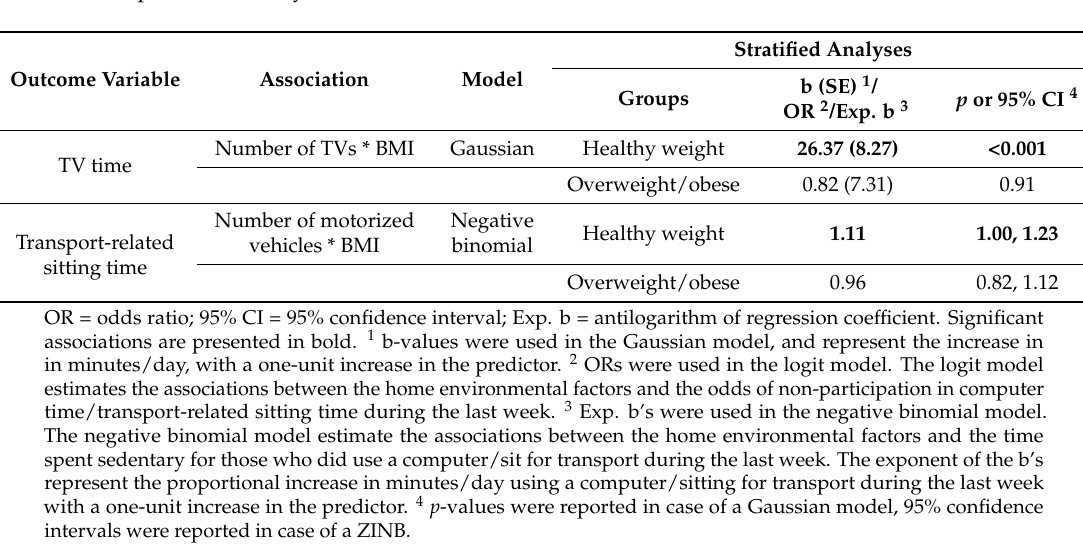
Table 3. Socio-demographic and BMI stratified associations between home environmental factors and domain-specific sedentary